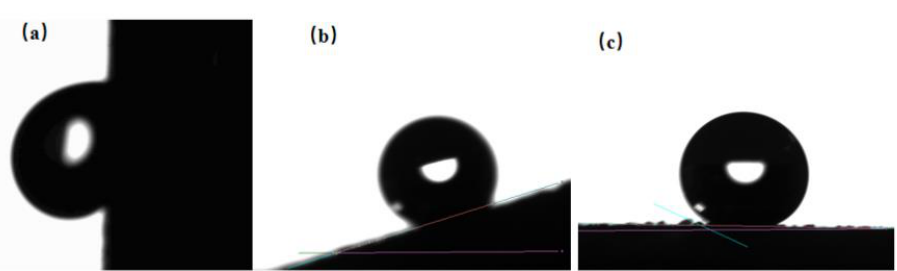
Figure 9. Water droplet shape showing roll angles on ( a ) insulator surface, ( b ) PDMS surface, and ( c ) FAS-17-modified nano-SiO 2 /PDMS surface.